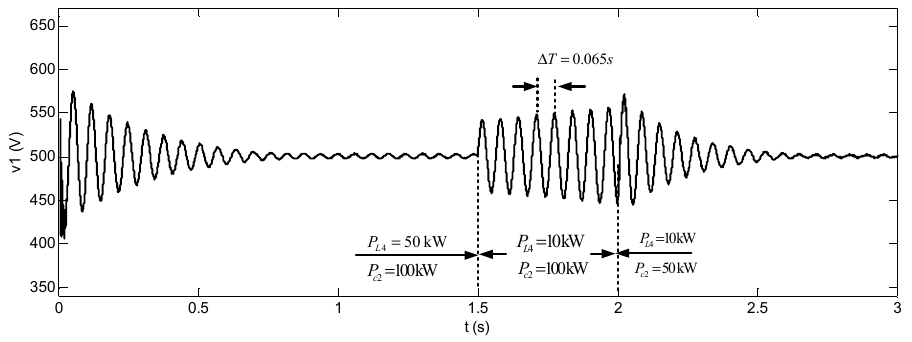
Figure 16. The node 1 voltage